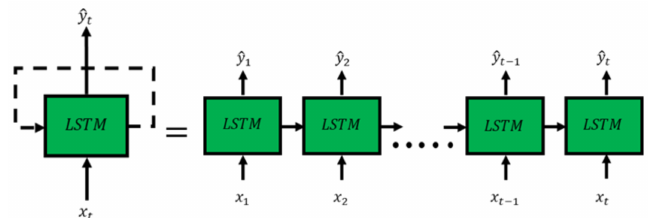
Figure 2. Unrolled LSTM